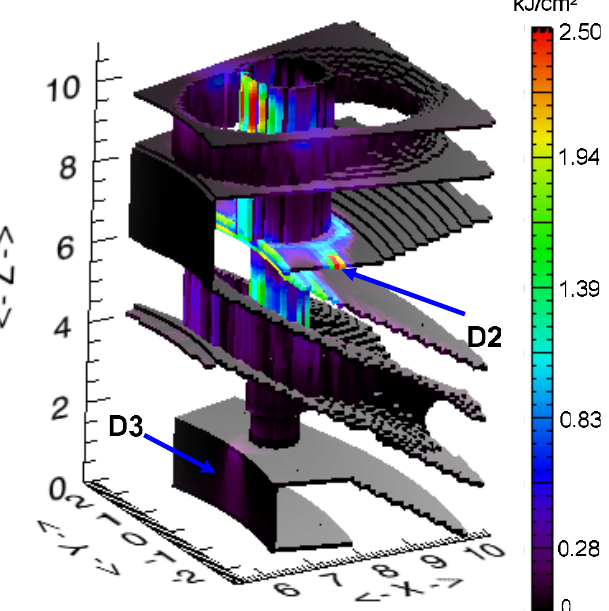
FIG. 8. (Color) Extended view of electron energy deposition on additional structures not shown in Fig. 7. Points labeled D2 and D3 are discussed in the text.